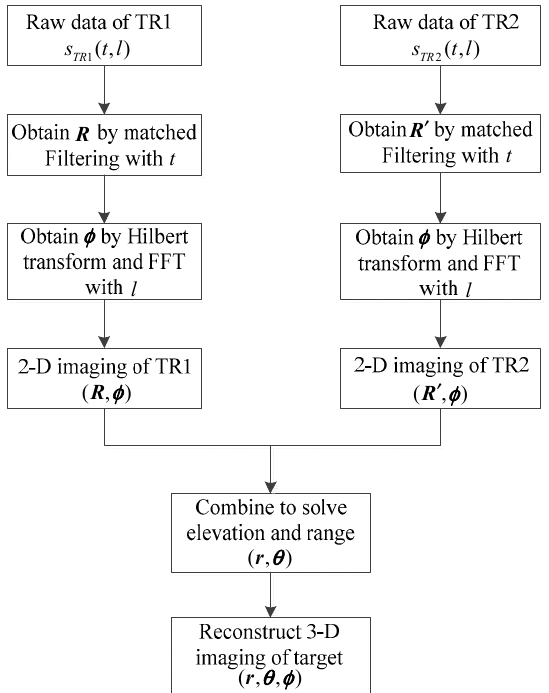
Figure 5. The flow of 3-D imaging method.